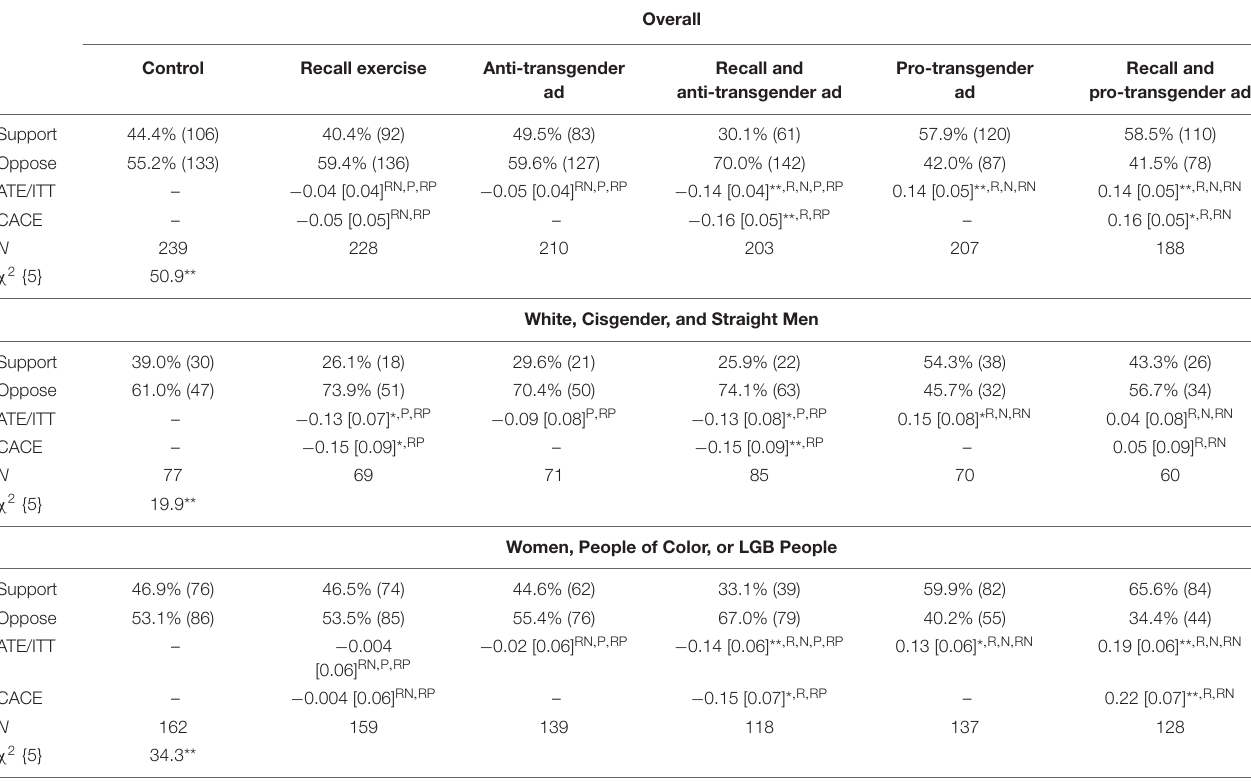
Women, people of color, or LGB